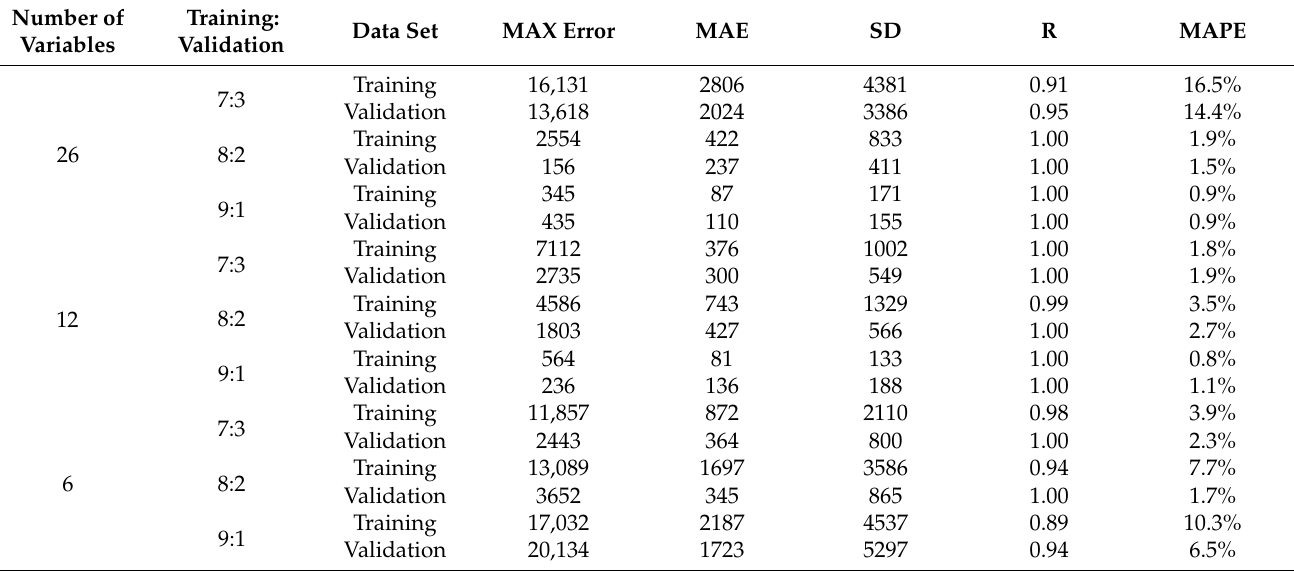
Table A4. Analysis of the results of the BPNN model for electricity consumption.